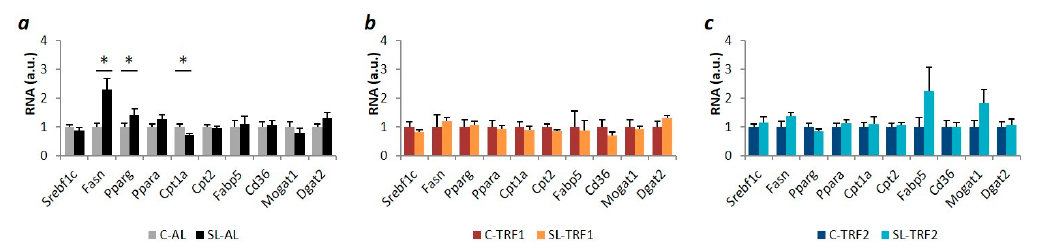
Figure 3. Time Restricted Feeding (TRF1) and (TRF2) restored the expression of genes involved in lipid synthesis and oxidation. ( a ) mRNA content (qPCR) of lipid-related genes in ad lib-fed (AL) mice ( n ≥ 10 both, control ( c ) and small litter (SL)), TRF1 mice ( n ≥ 5 both, C and SL) ( b ) and TRF2 mice ( n ≥ 5 both, C and SL) ( c ). All samples were collected at the end of the 4-weeks intervention at ZT0. Data represent means ± S.E.M. * p < 0.05 versus C-AL mice.